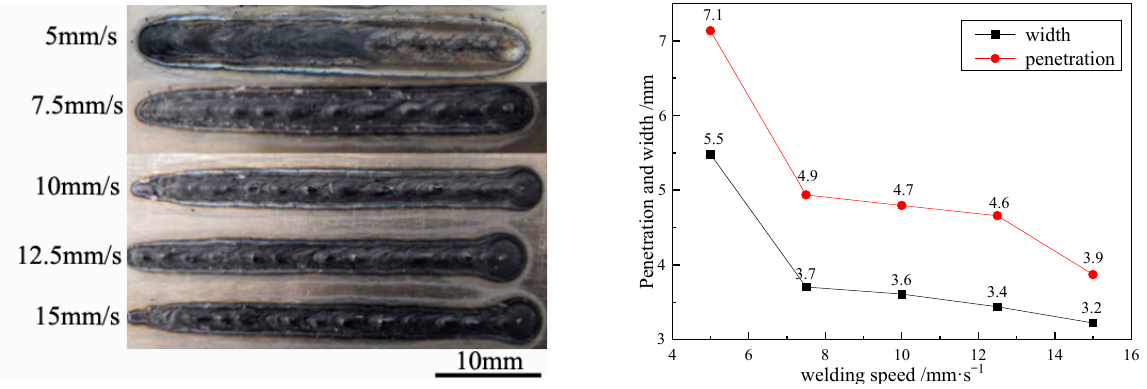
Figure 4. Effect of welding speed on weld macromorphology, penetration depth, and width. When the laser power is 3000 W and the welding speed is 5 mm/s, the weld depth and width at different water depths are shown in Figure 5. It can be seen from the figure that there is little difference in the penetration depth between the shallow water and the air welding, indicating that the laser energy loss is low in shallow underwater welding.